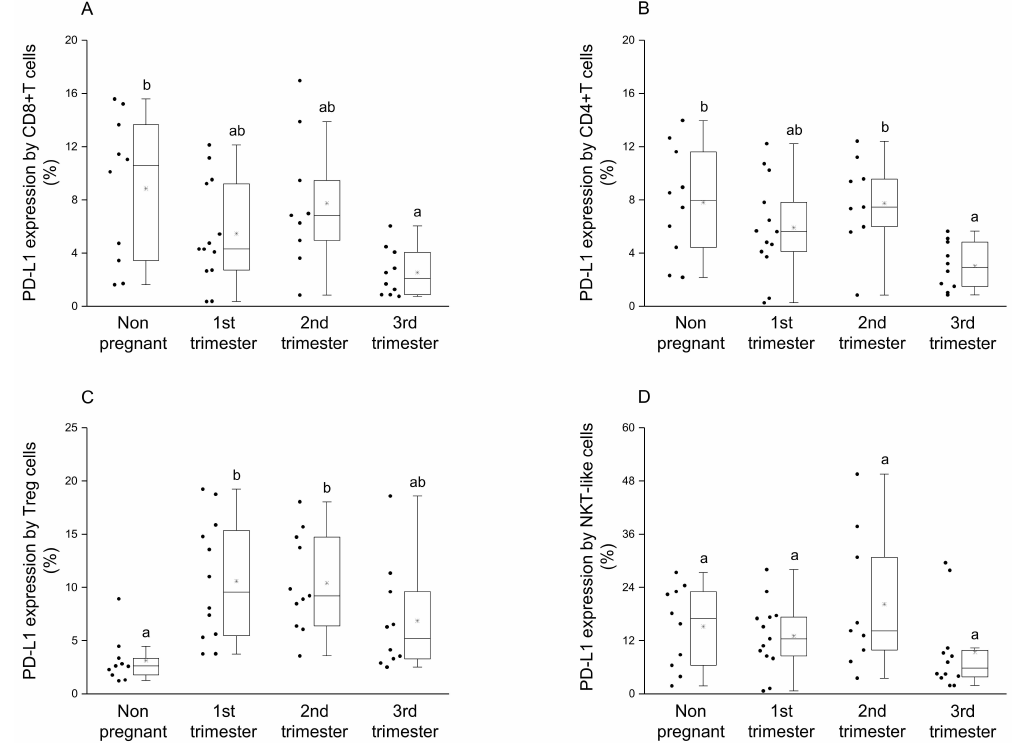
Figure 2. PD-L1 ligand expression by di ff erent T cell subpopulations throughout pregnancy and in nonpregnant women. The expression of PD-L1 molecule by CD8 + T cell ( A ), CD4 + T ( B ), Treg ( C ) and NKT-like ( D ) subpopulations. The solid bars represent medians of 10, 13, 10 and 12 samples, the boxes indicate the interquartile ranges, and the lines show the most extreme observations. Di ff erences were considered statistically significant for p -values ≤ 0.05. Variables with the same letter indicate no statistically significant di ff erence, while di ff erent letters indicate a statistically significant di ff erence.